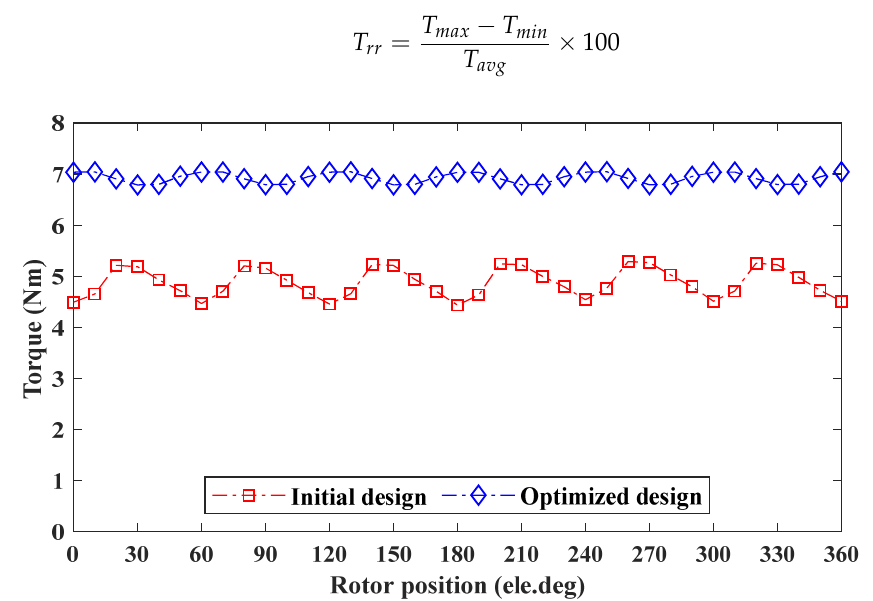
Figure 14. Instantaneous toque profile of initial and optimized design.